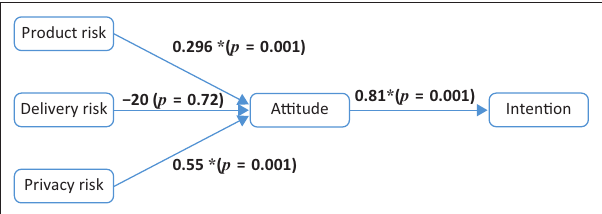
FIGURE 2: Structural model with standardised coefficients.